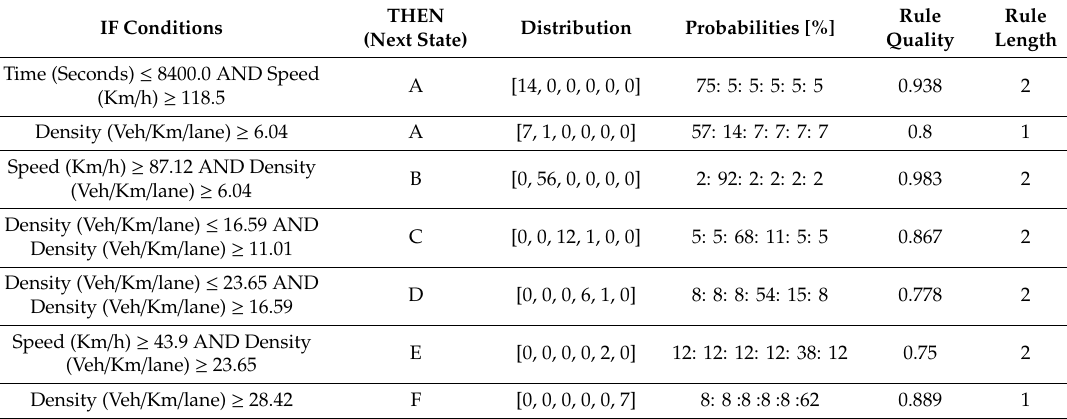
Table A2. If–then rules for the next 10-min